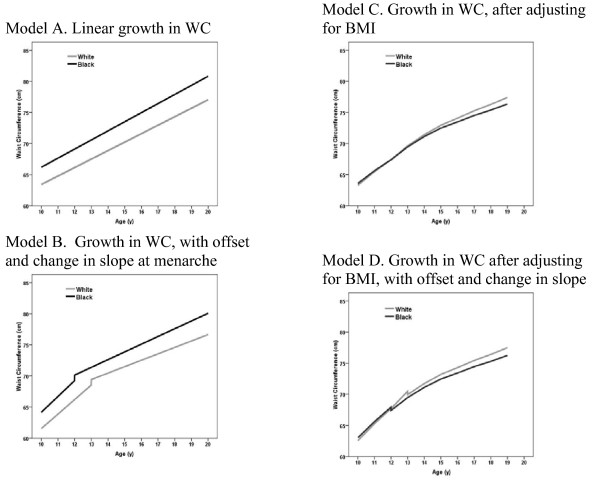
Prototypical waist circumference trajectories. Longitudinal waist circumference changes for a prototypical subject with a BMI equal to the mean